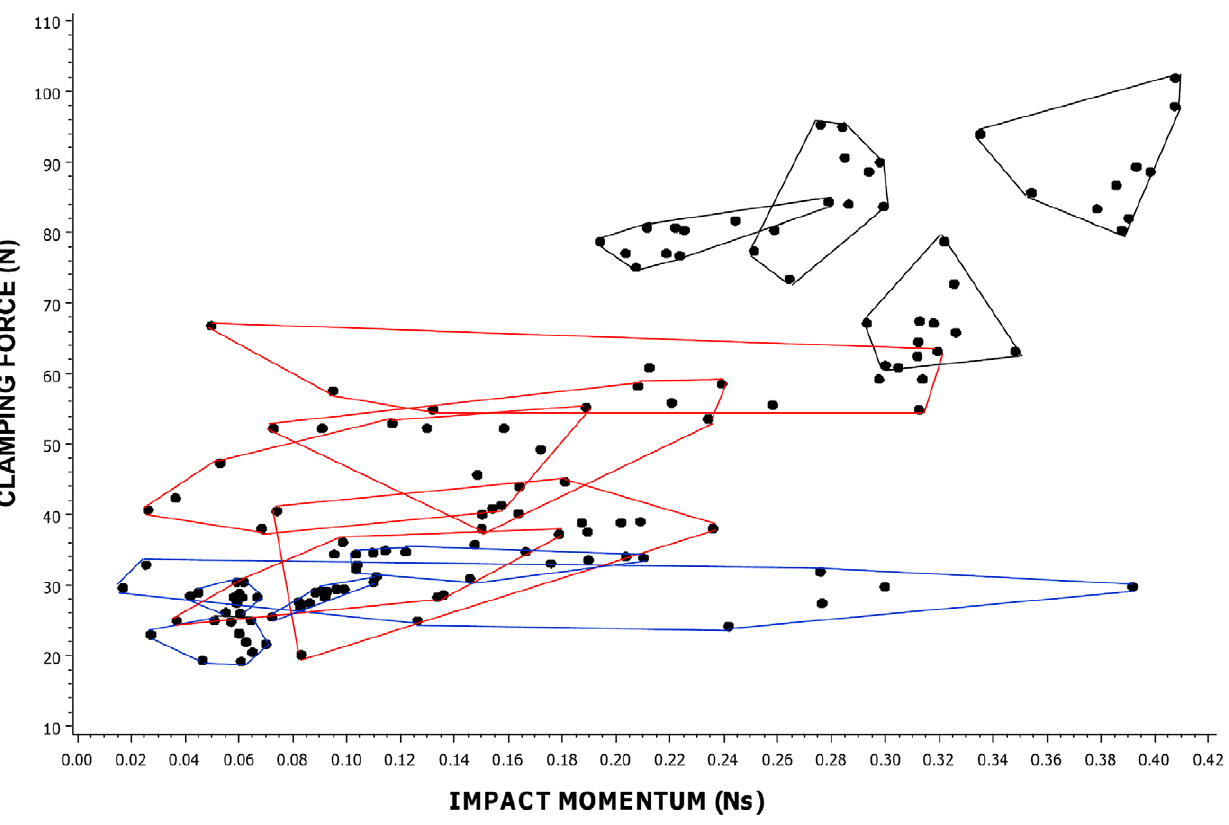
Figure 4. Raw data for impact momentum against clamping force in mole traps. Each point represents an individual trap and traps of the same trap type/manufacturer combination are enclosed within the same polygon. Trap types are: blue=Duffus, red=scissors, black=talpa.